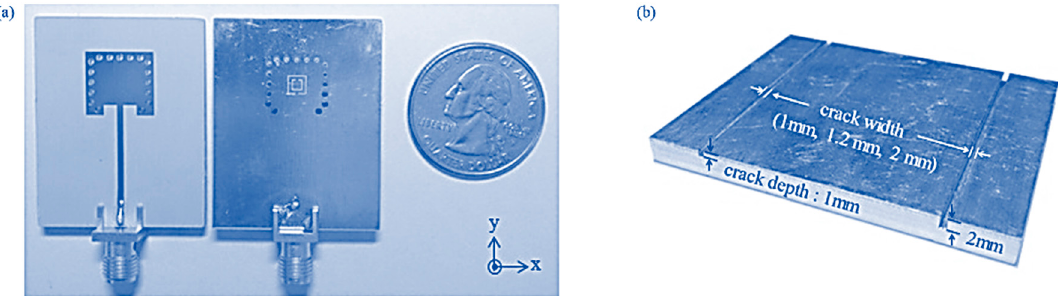
Figure 30. Fabricated sensor and aluminum sample: ( a ) top and bottom views of the sensor and ( b ) aluminum sample; (from [41]; copyright © 2014; reproduced with permission).